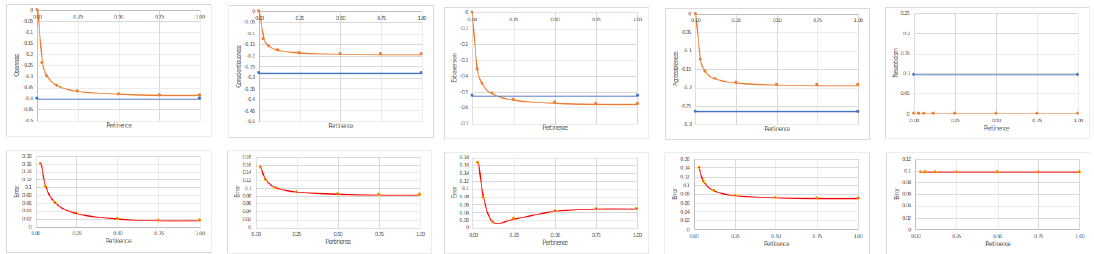
Figure 14. Error graphics from Pity input emotion—OCEANS’s factors.